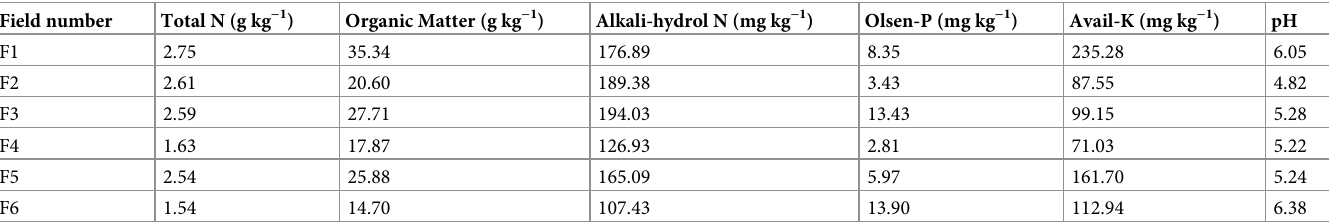
Table 1. Soil chemical properties of the 0–20 cm layer of the experimental